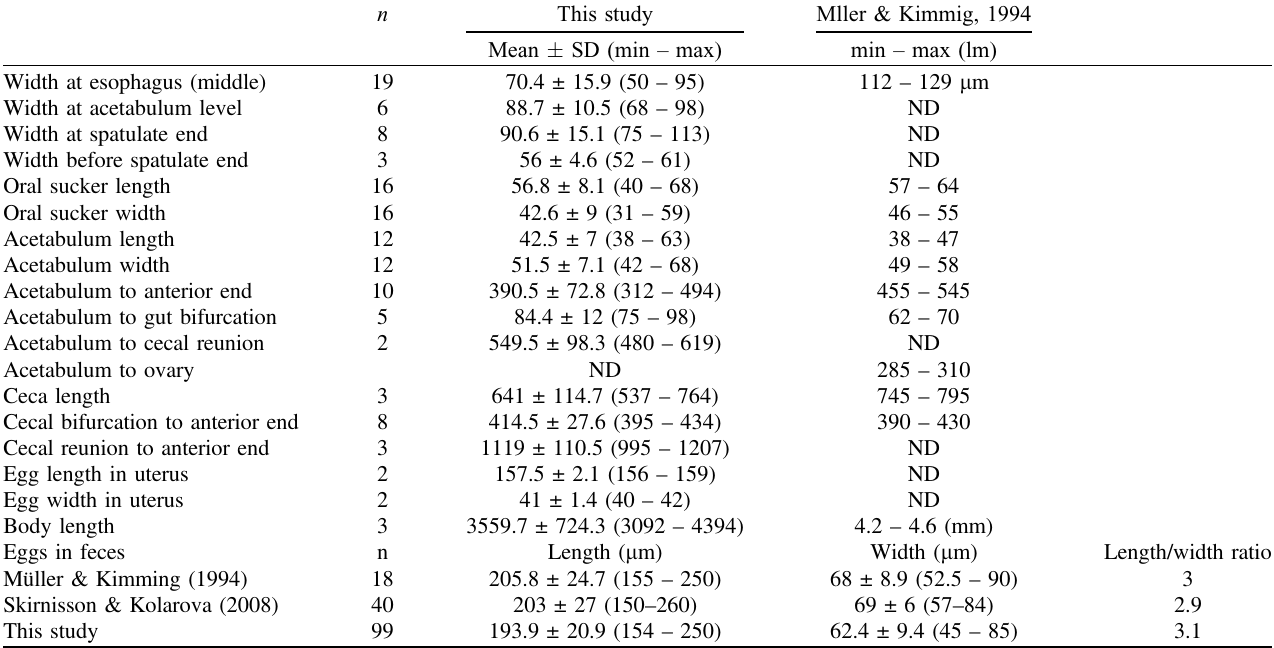
Table 3. Measurements of fresh mounts of female worms from duck hosts Anas platyrhynchos domesticus represented as mean ±